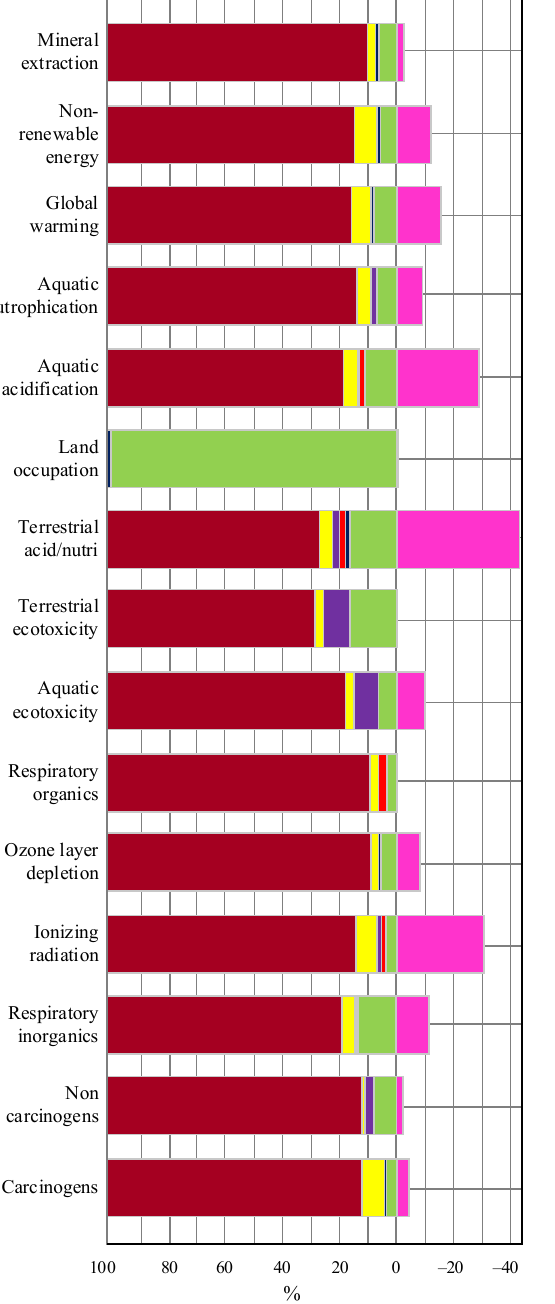
Fig. 2. IMPACT 2002+ midpoint impact categories for the production of 1 kg rigid polyurethane foam in